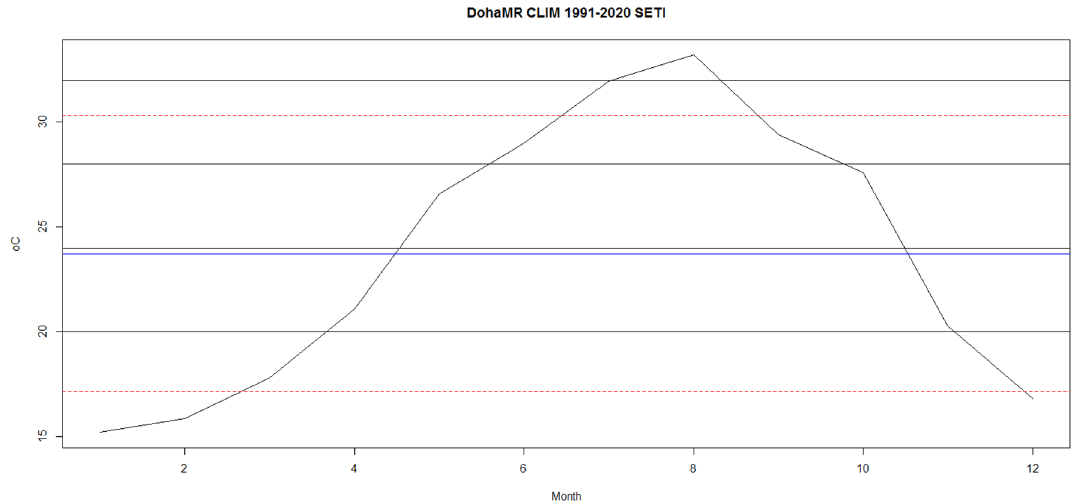
ble average and the red dashed line is the standard deviation- based interval, and the solid lines are the thresholds established in the